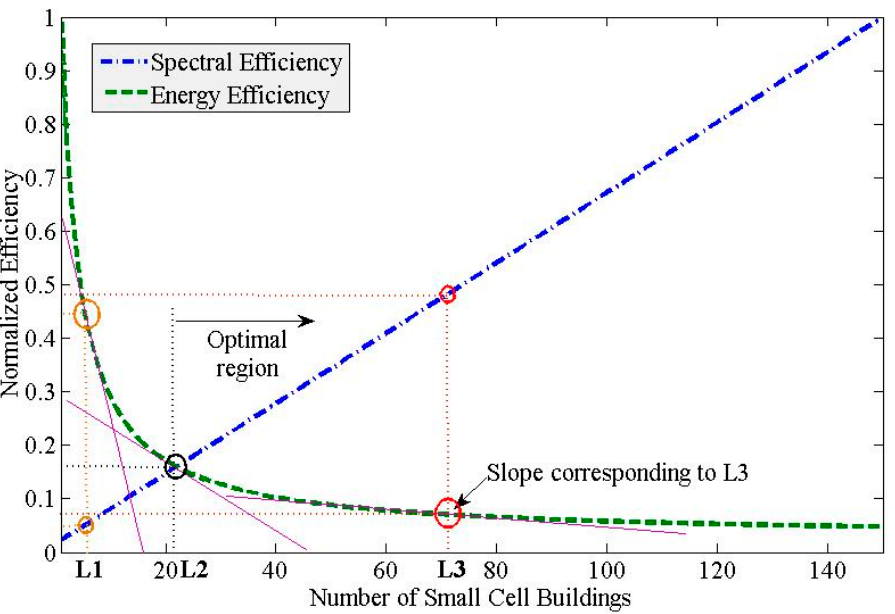
Figure 8. Normalized spectral efficiency and energy efficiency performances of MNO 1 for L ≥ 1 and T nABS,1 = 4.